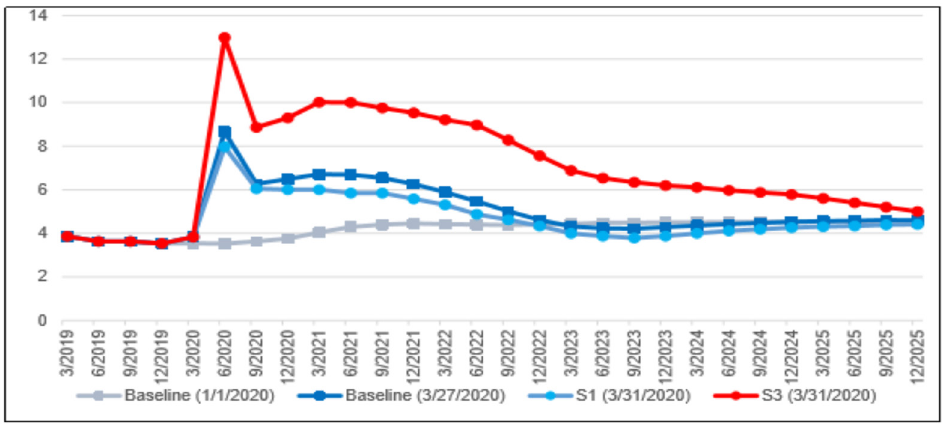
Figure 1: Moody’s